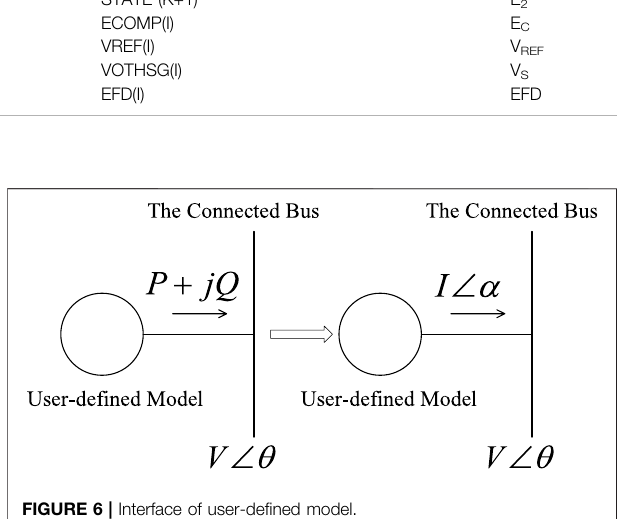
FIGURE 6 | Interface of user-de fi ned